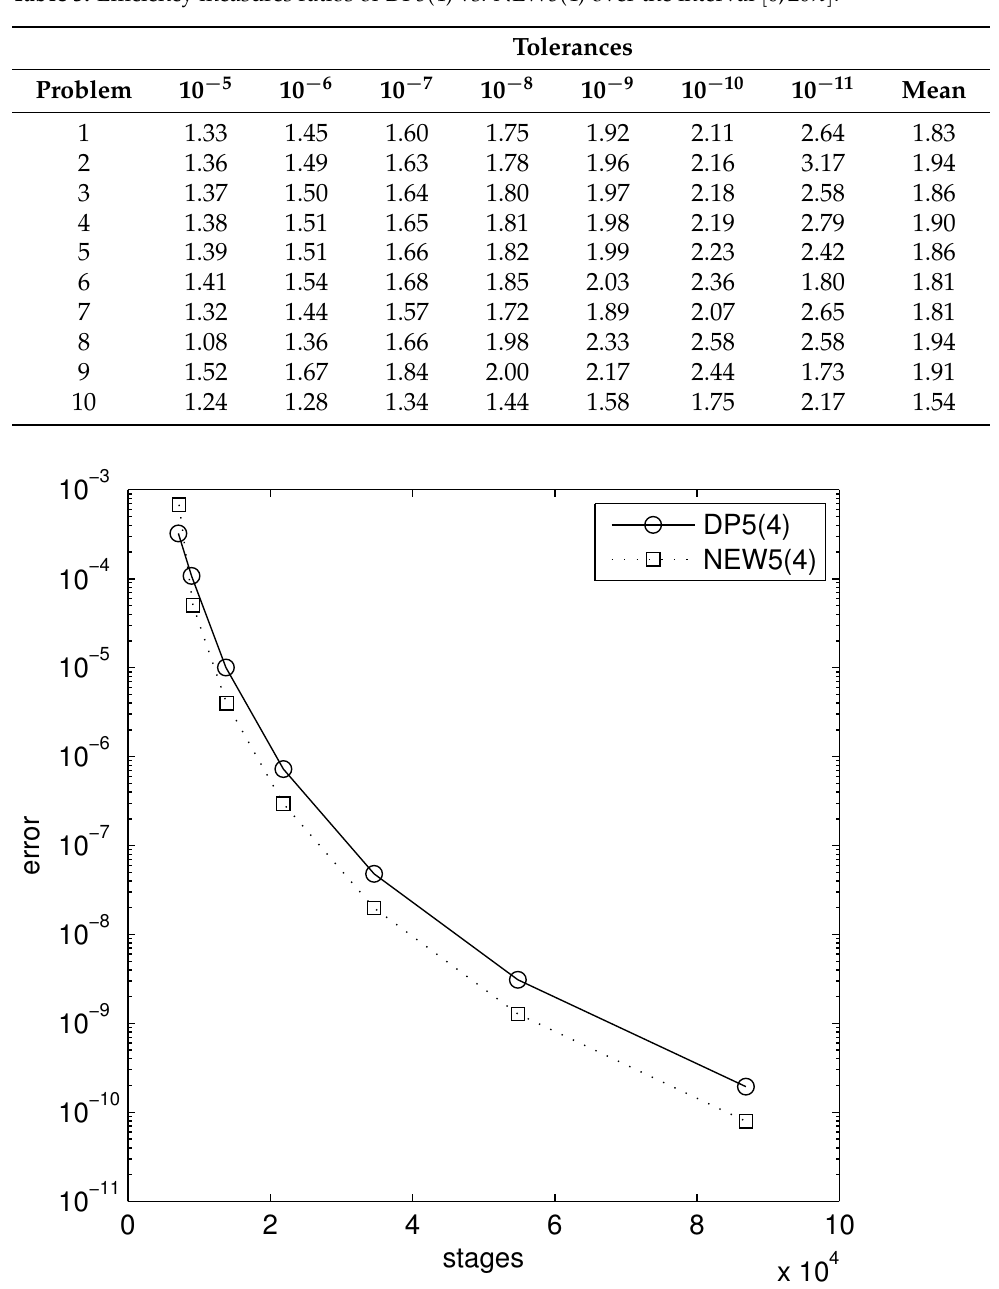
Figure 1. Results of DP5(4) vs. NEW5(4) for the Hyperbolic